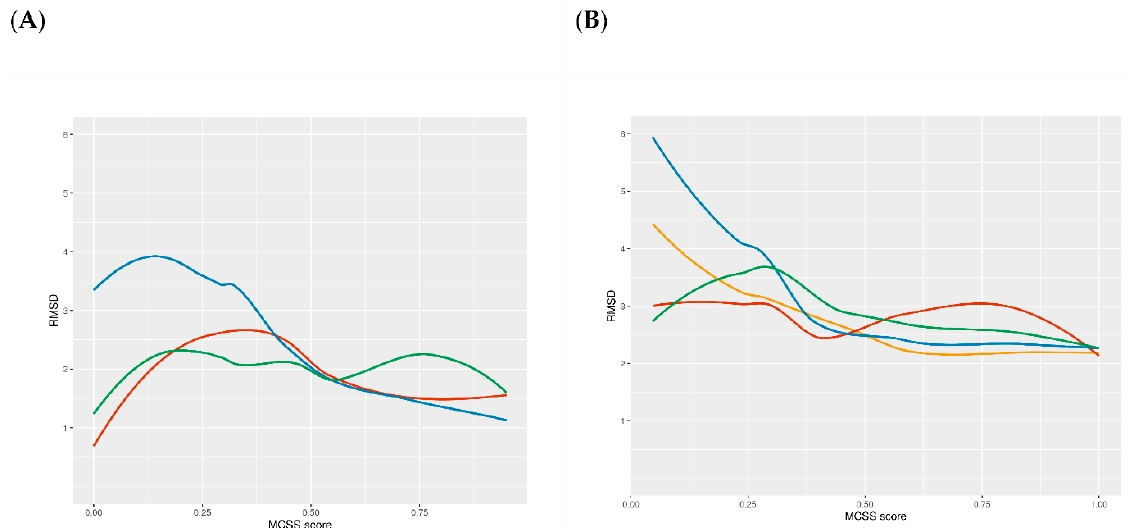
Figure 3. Differences in best pose predicted for target 5p8y from CELPP week 33. Image ( A ) corre- sponds to free docking with an RMSD of 4.09 Å. Image ( B ) is the best prediction obtained with pharmacophoric restraints (1.74 Å). Image ( C ) corresponds to the best pose using tethered docking, obtaining an RMSD of 0.95 Å. The red substructure indicates the tethered atoms.